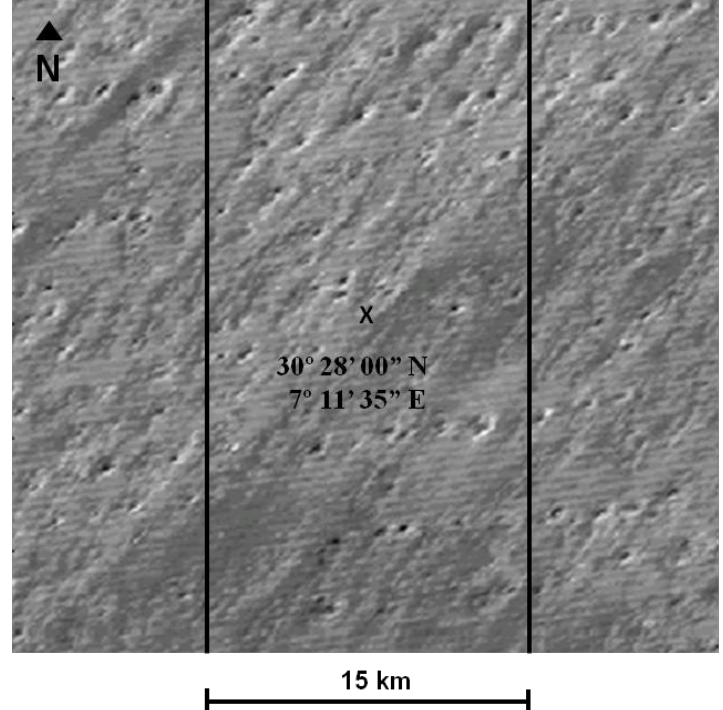
Figure 10. Illustration of the ground track of two TIRS arrays when imaging in side slither mode. The dark lines represent the ground tracks for a fore and aft looking array superimposed on a Landsat 5 image.